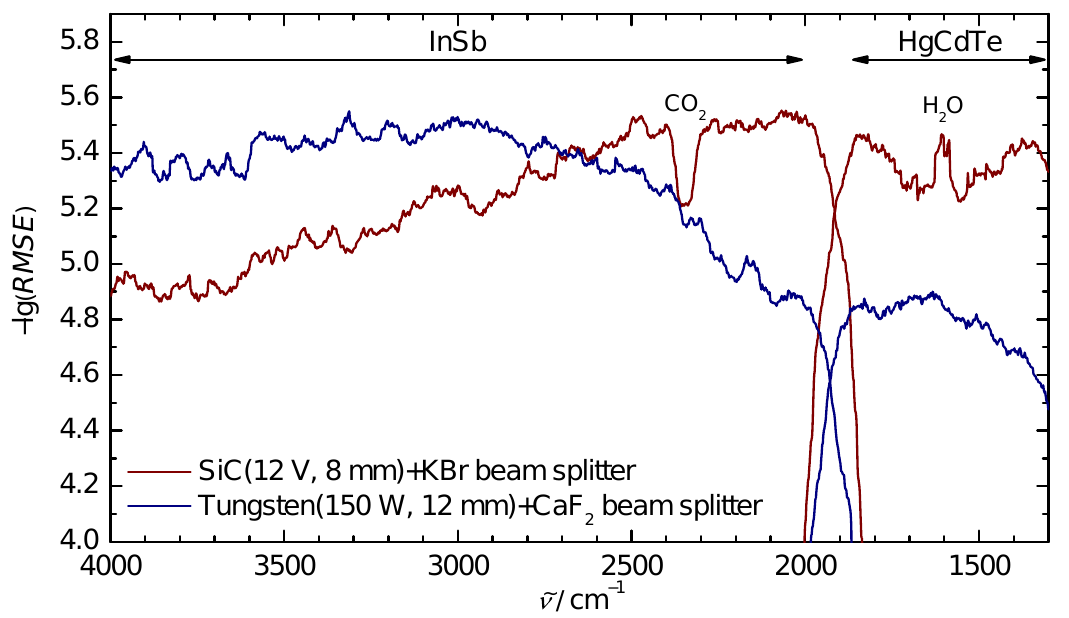
Figure 5. Sandwich detector performance with gratin optics, comparing the two channels for a tungsten source at 12 mm aperture and a SiC source at 8 mm aperture. Note that a higher value means lower noise and thus better performance.